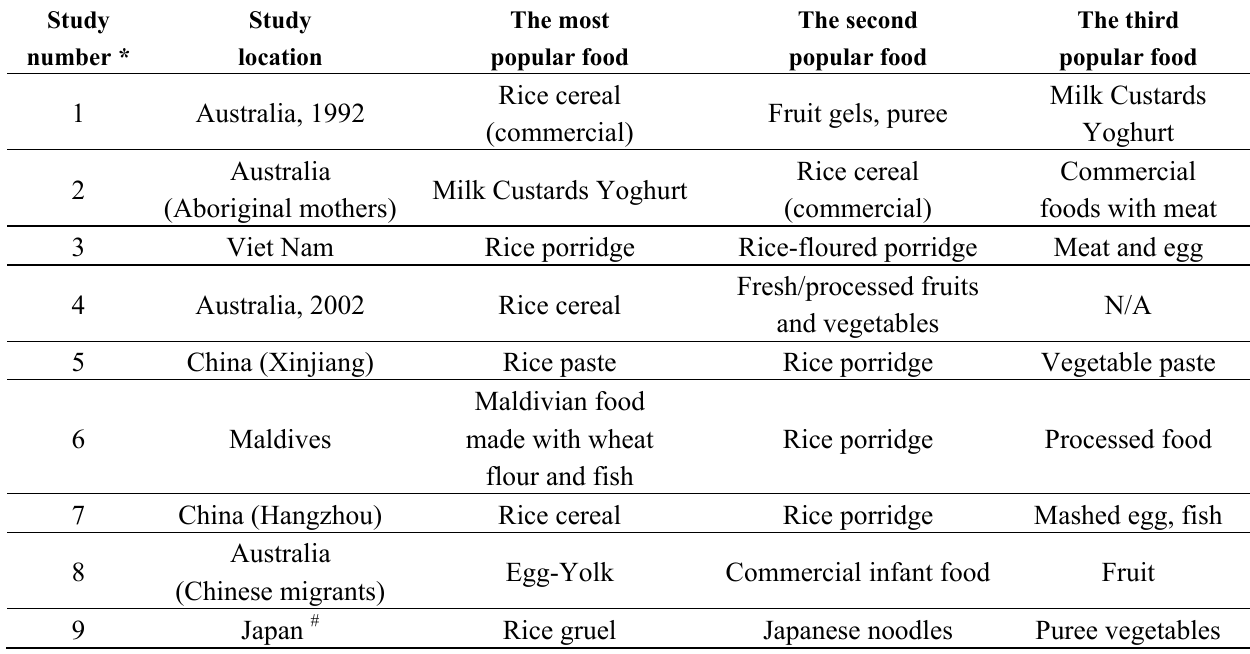
Table 4. The type of solid foods given to infants in the Asia Pacific